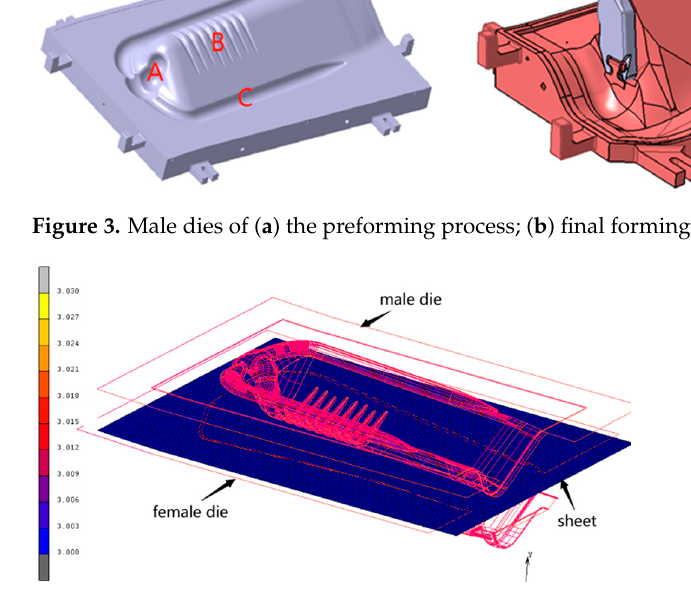
Figure 4. Initial FEM model.